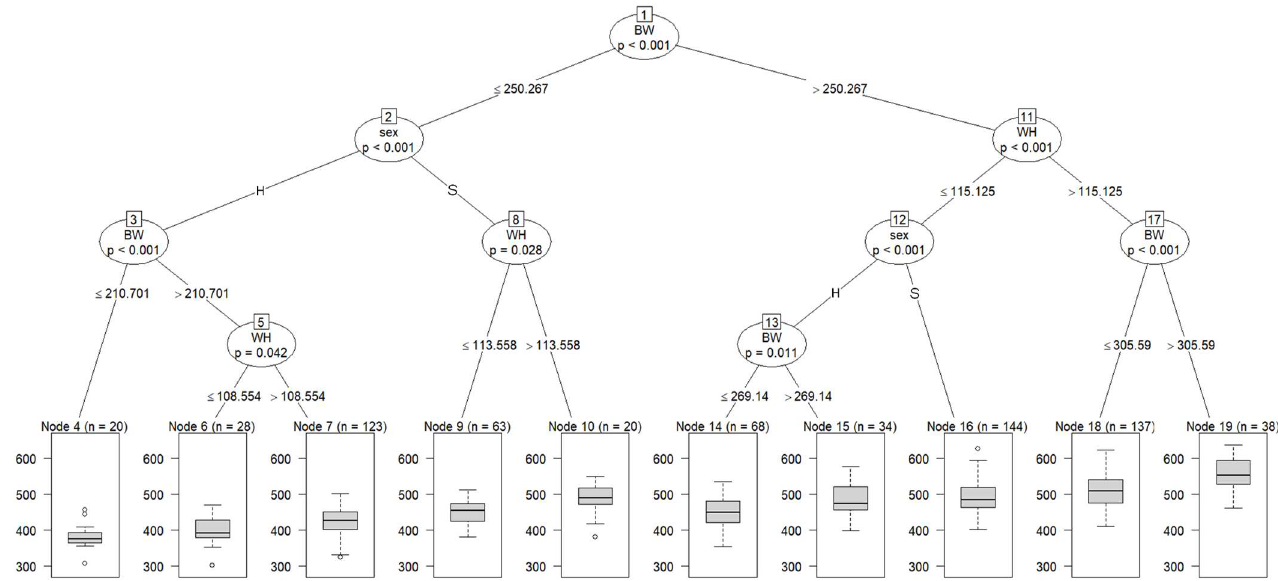
Figure 2. The graphical model of regression tree for carcass weight. A total of 675 animals with the adjusted phenotypic values for the fattening starting age (8 months) and the slaughter age (29 months) were used in the analysis. Carcass weight was used as a dependent variable, and sex (S = steer, H = heifer), 3 growth performance traits, and 8 blood metabolites were used as independent variables. Abbreviations of traits are shown in Table 1.